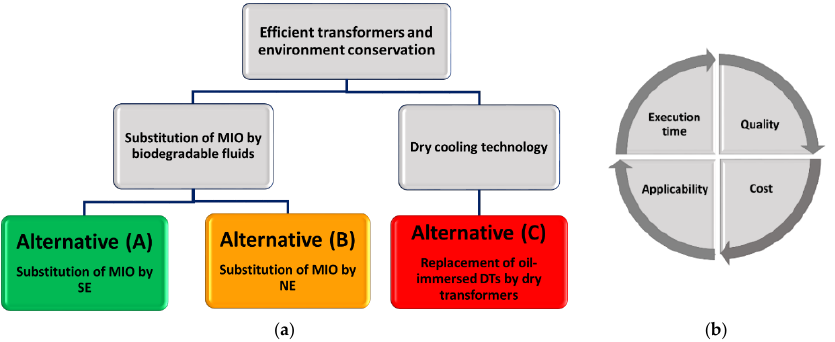
Figure 10. Solution alternatives and differentiation criteria: ( a ) the nominated three alternatives; ( b ) the four criteria for differentiation between alternatives. Table 2. Application of weighting and ranking method.